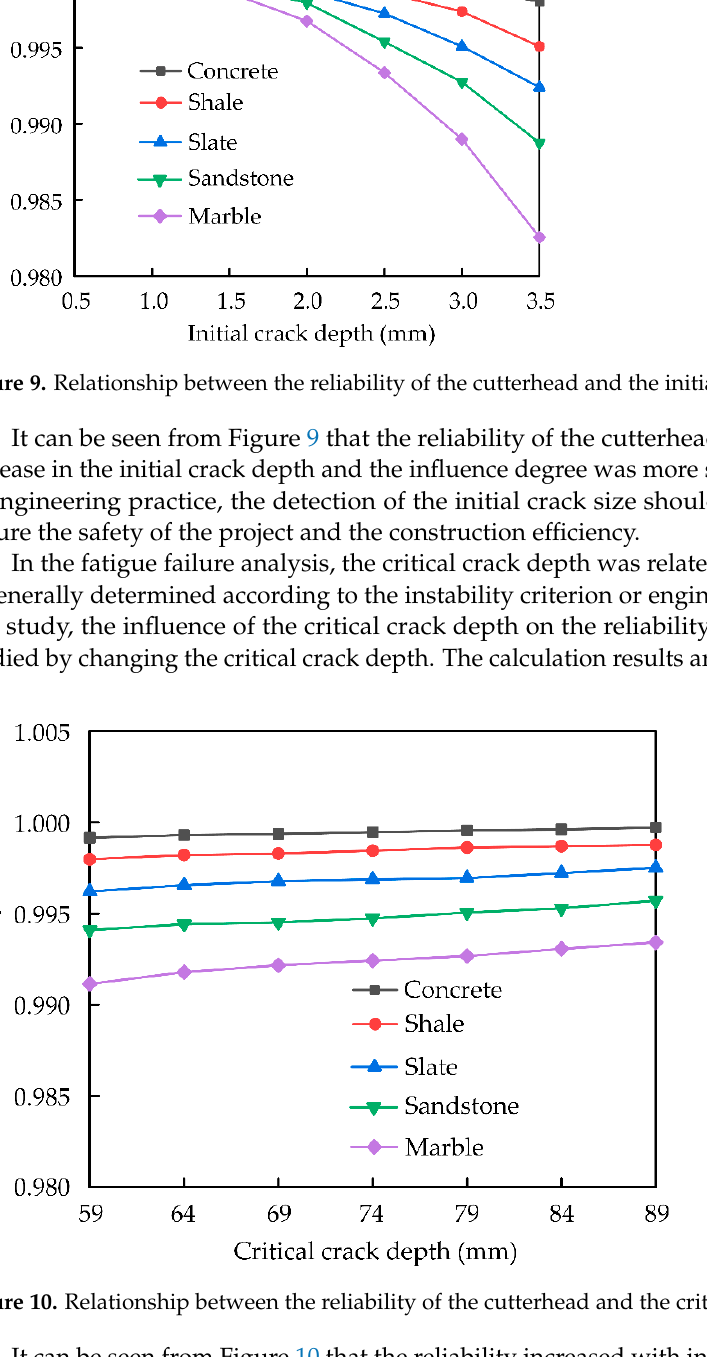
Figure 10. Relationship between the reliability of the cutterhead and the critical crack depth.